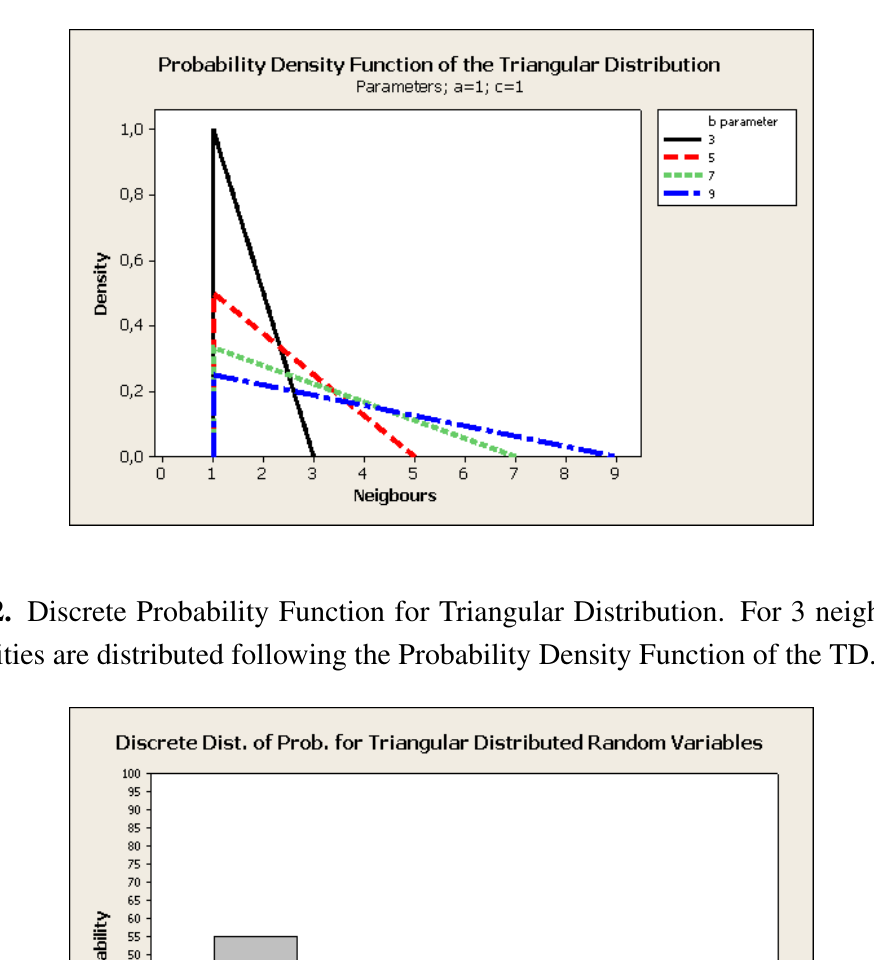
Figure 1. Plot of different probability density function of the Triangular Distribution. The X axis indicate the number of eligible neighbours.